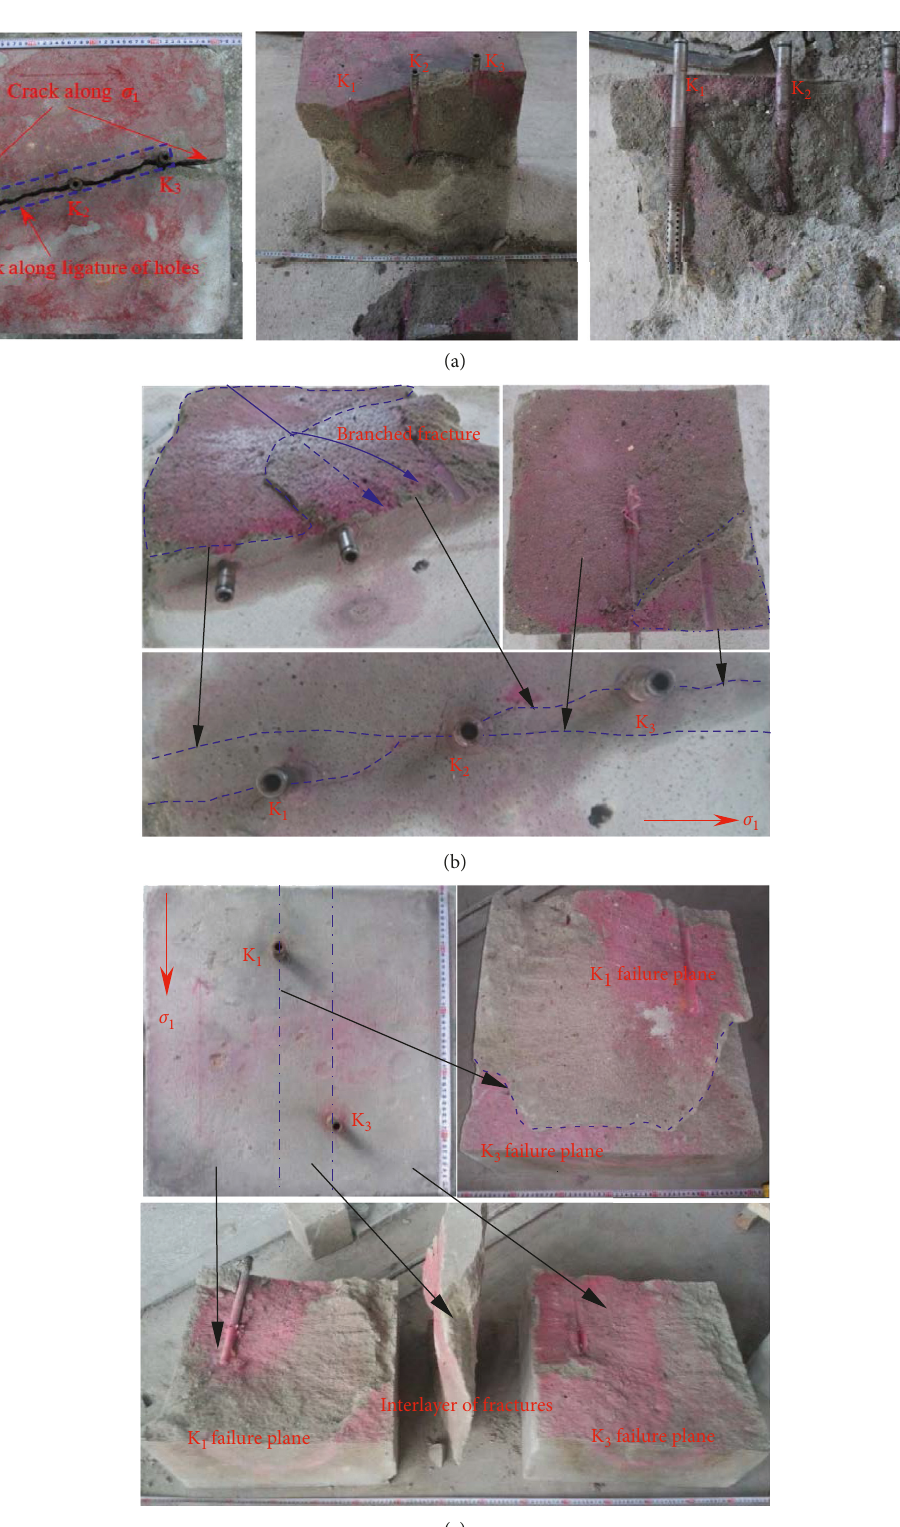
Figure 5: Crack propagation of directional hydraulic fracturing controlled by dense linear multihole drilling. (a) Crack along ligature of holes (specimen A). (b) Hydraulic cracks along ligature of holes and σ 1 (specimen B). (c) Hydraulic cracks totally along σ 1 (specimen